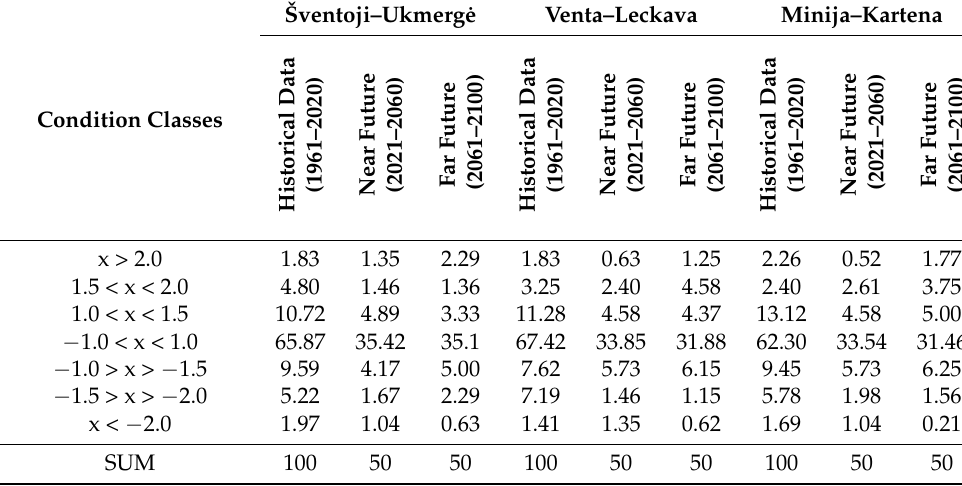
Table 8. Changes of RDI (x in Table) according to RCP 8.5 for three rivers.